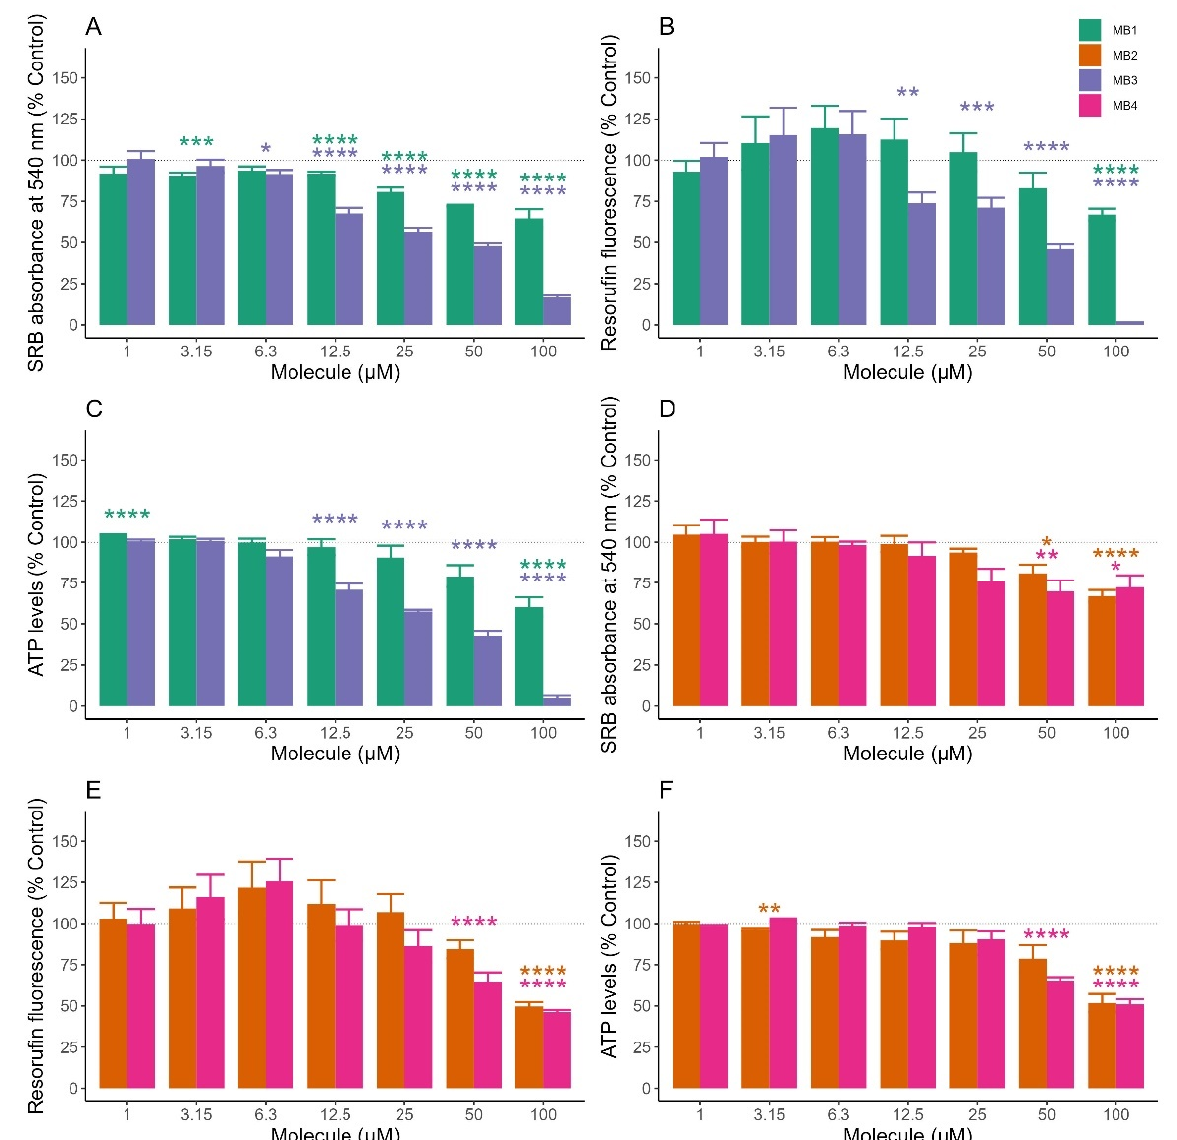
Figure 3. Effects of hydroxybenzoic-based mitochondriotropic antioxidants MB1-MB4 on cell mass ( A , D ), metabolic activity ( B , E ), and intracellular ATP ( C , F ) of normal human dermal fibroblasts (NHDF). Normal human dermal fibroblasts were treated with increasing concentrations of the different molecules for 48 h. Cellular mass, metabolic activity, and ATP levels were evaluated using sulforhodamine B (SRB) assay, resazurin reduction assay, and CellTiter-Glo Luminescent Cell Viability Assay, respectively. Data are the mean ± SE of four independent experiments. The results are expressed as a percentage of the control. Statistically significant differences between control (CTL) and treated groups were evaluated using a t -test. **** p < 0.0001, *** p < 0.001, ** p < 0.01 and * p < 0.05 compared to the respective control (CTL, vehicle-treated cells), with the colours green, orange, blue and pink to correspond to each compound MB1, MB2, MB3 and MB4, respectively. Our data also showed a decrease in cell mass (Figure S2A), metabolic activity (Figure S2B) and intracellular ATP levels (Figure S2C) in NHDF cells treated with MitoQ and SkQ1 at concentrations above 1 µ M. These results suggested that all MitoBENs were less toxic than both mitochondria-targeted antioxidants in NHDF